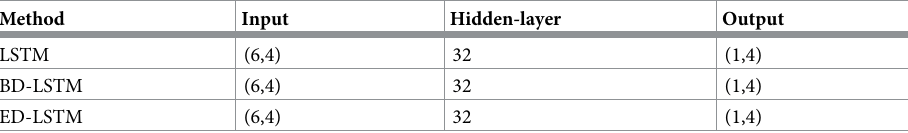
Table 6. Respective LSTM model topologies for the multivariate